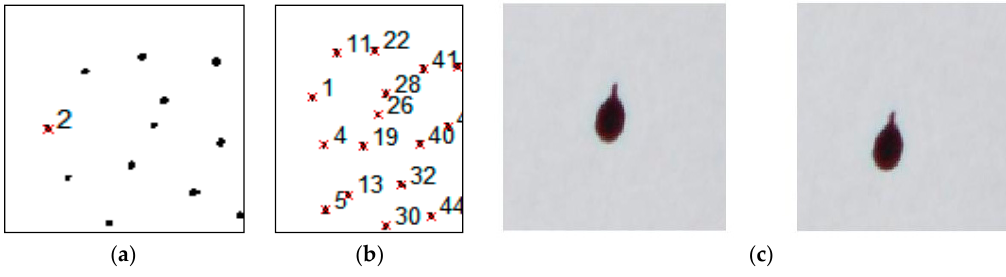
Figure 4. ( a , b ) Incongruent enumeration between left “a” and right “b” images. ( c ) Image regions acquired at different moments containing the same marker.